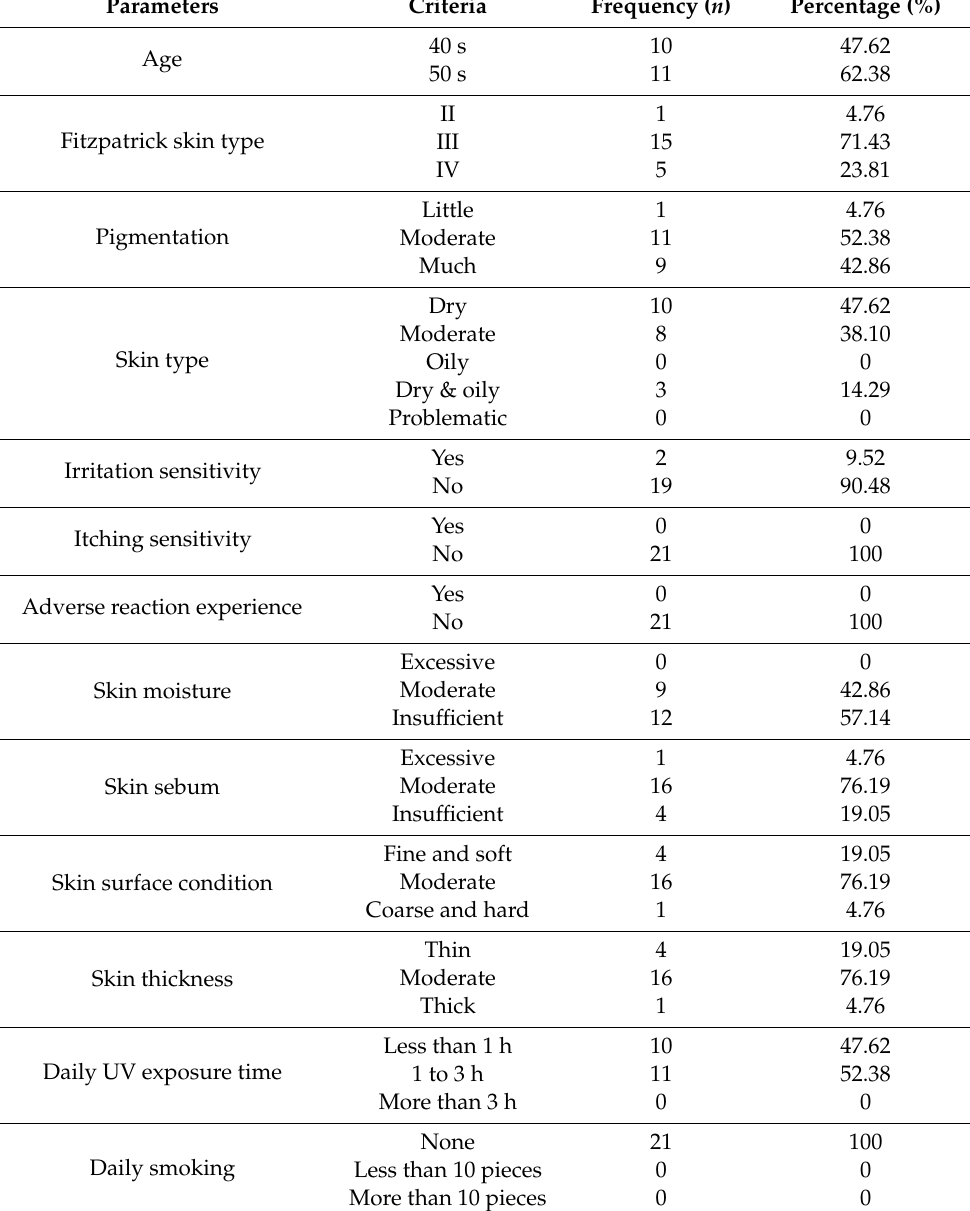
Table 3. Skin characteristics of subjects in the skin depigmentation e ffi cacy test ( n =